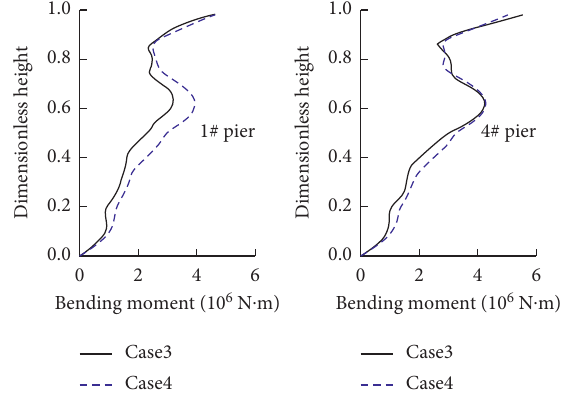
Figure 10: Bending moment envelopes of pile No. 1 in Cases 3 and 4.